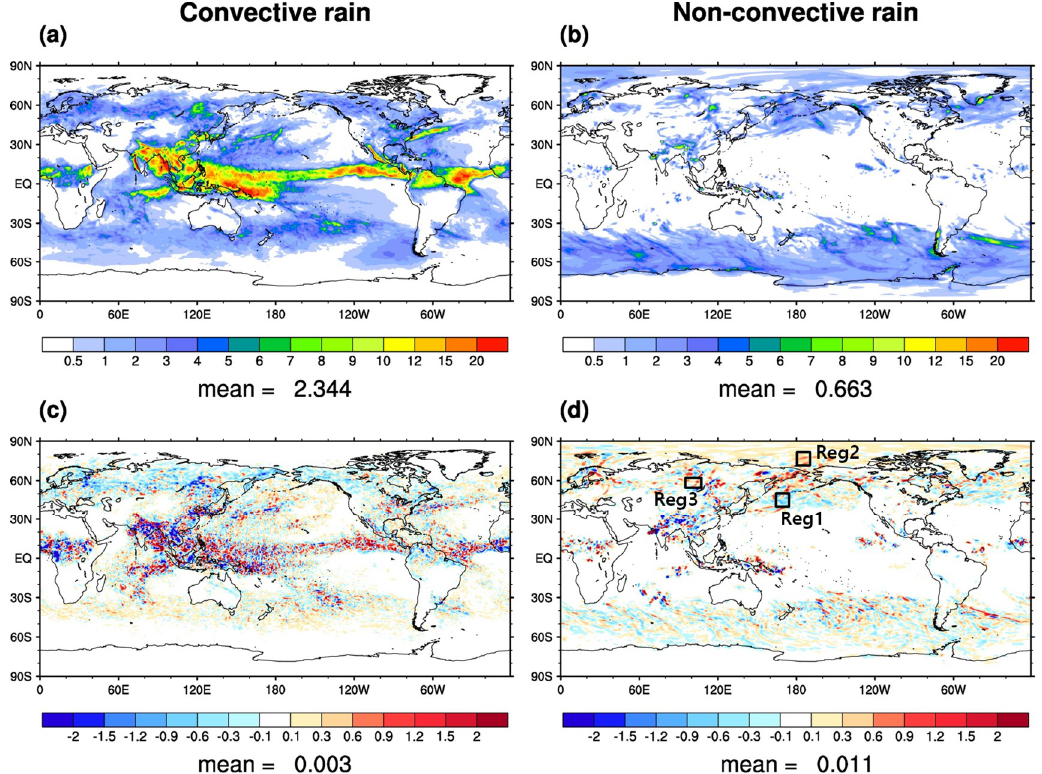
Figure 4. Horizontal distributions of ( a , b ) precipitations for the CTL run and ( c , d ) differences in precipitations (EXP minus CTL). The left (right) panel is for convective (non-convective) rain. Values are in mm day − 1 and global averaged values are also shown at the bottom of each plot. The three selected regions for investigating the non-convective precipitation change for EXP are plotted in Figure 4d.